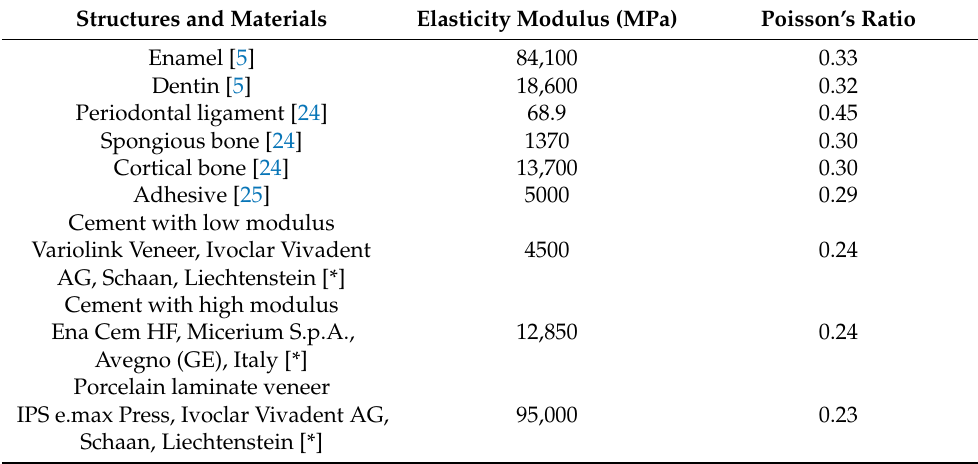
Table 1. Material properties of the tooth layers and restorative materials.